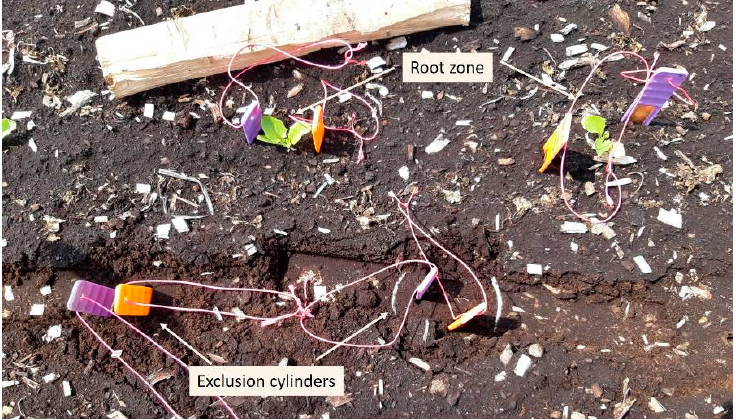
Table 2. Burial and retrieval dates for the PRS ® probes and related periods.